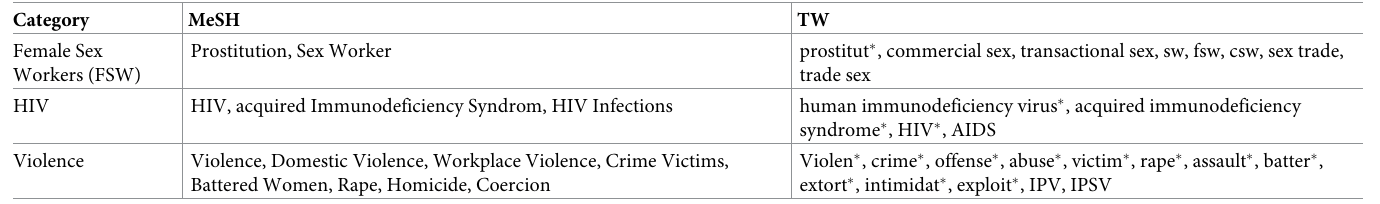
Table 1. Medical Subject Headings (MeSH) and Text Words (TW) used to retrieve relevant articles. Category